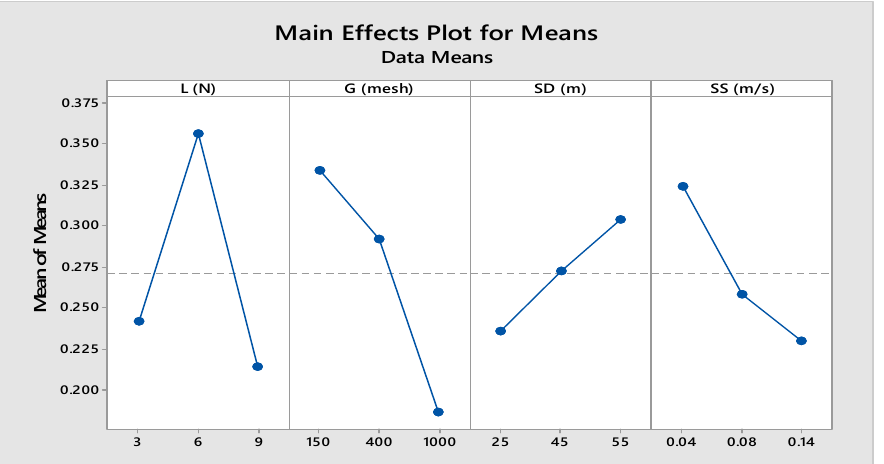
Figure 9. Main effect plot for mean μ of PTFE matrix composites.